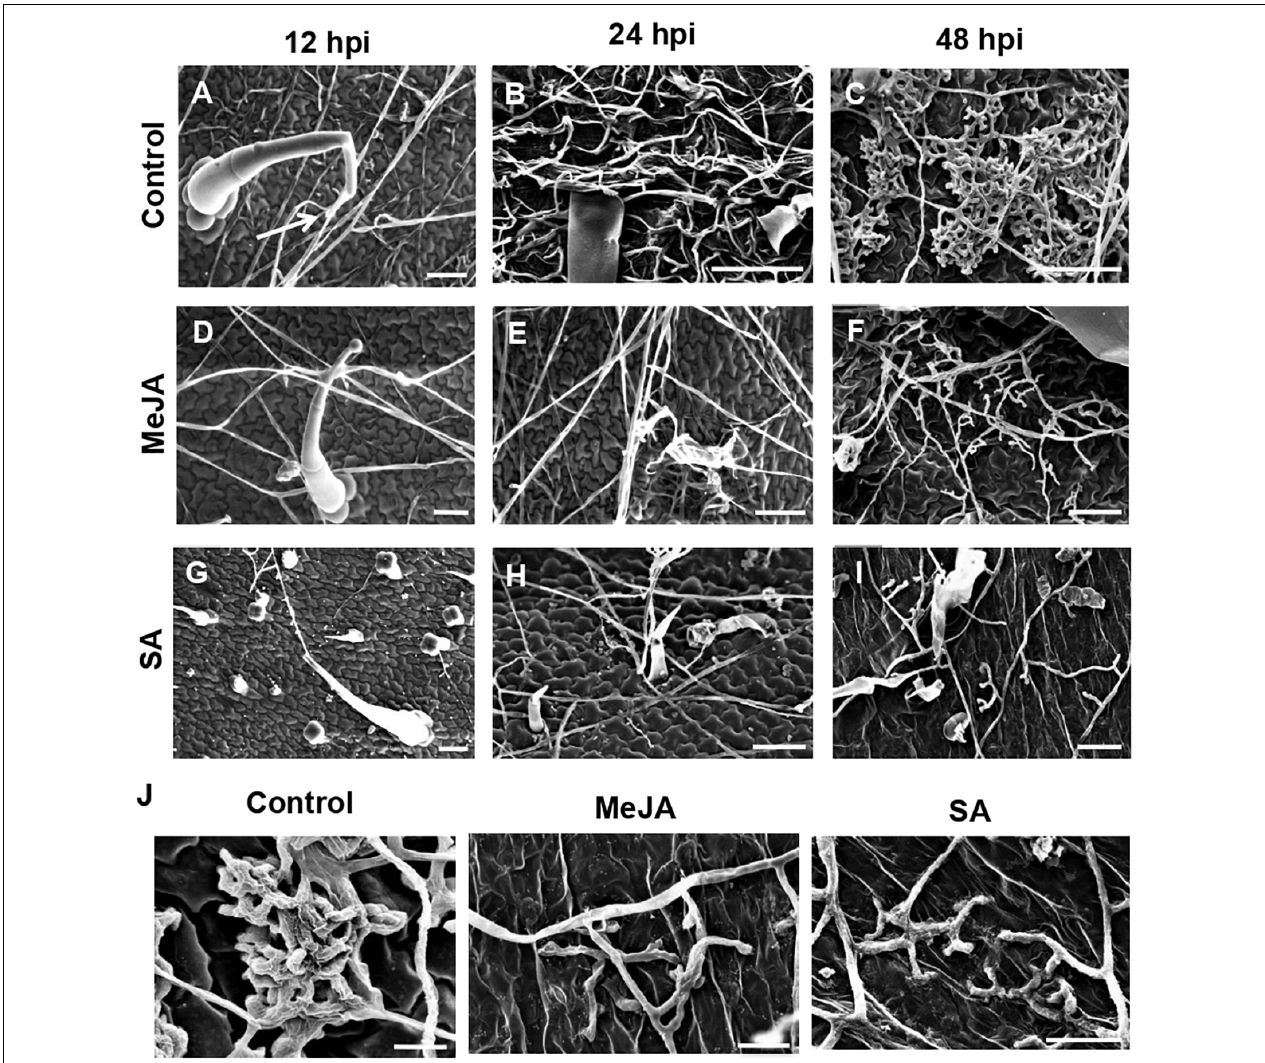
FIGURE 4 | Scanning Electron Microscopy to observe differential behavior of R. solani hyphae on the surface of primed and control leaves, showing interaction with trichomes and formation of infection cushions during early stages of infection. (A) Control leaf showing close association of hyphae with leaf trichome at 12 hpi (Arrow) (B) Hyphae making intimate contact with the control leaf surface forming network of hyphae at 24 hpi. (C) By 48 hpi, coalesced infection cushions cover most of the leaf surface in control leaves. (D) In the MeJA-primed leaves, the hyphae avoid contact with leaf surface, interacting only with the trichomes at 24 dpi. (E) On MeJA-primed leaves, the hyphae show sparse growth with less hyphal branching and (F) initiation of infection cushions with clubbed bifurcating hyphae, is delayed to 48 hpi. (G–I) The SA-primed leaf surface showing least hyphal growth with superficial hyphal contact with leaf surface and no infection cushion even at 48 hpi. Bar = 50 µ m. (J) Close-up views of infection cushions or hyphal aggregations in respective experimental sets at 48 hpi. Bar = 20 µ